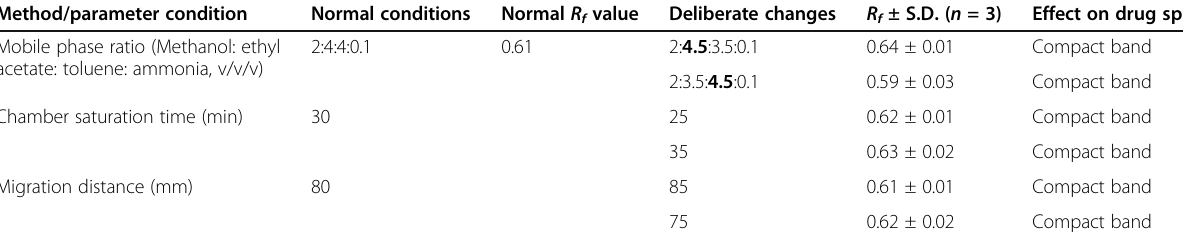
Table 2 Summary of robustness studies Method/parameter condition Normal